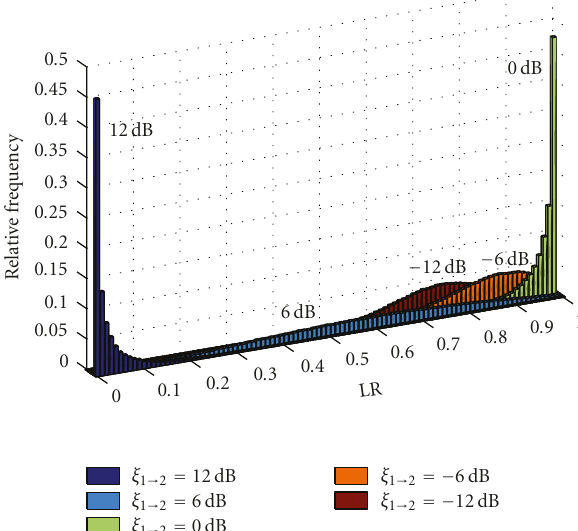
= 4 σ 2 N 1 ). ξ 1 denotes the 2 Figure 7: Histograms of the LR values for constant SNR ξ 1 = 5 dB. The amplitudes of the time-domain signal are Gaussian i.i.d. The distribution is broadest at an SNR increase between roughly 0 and